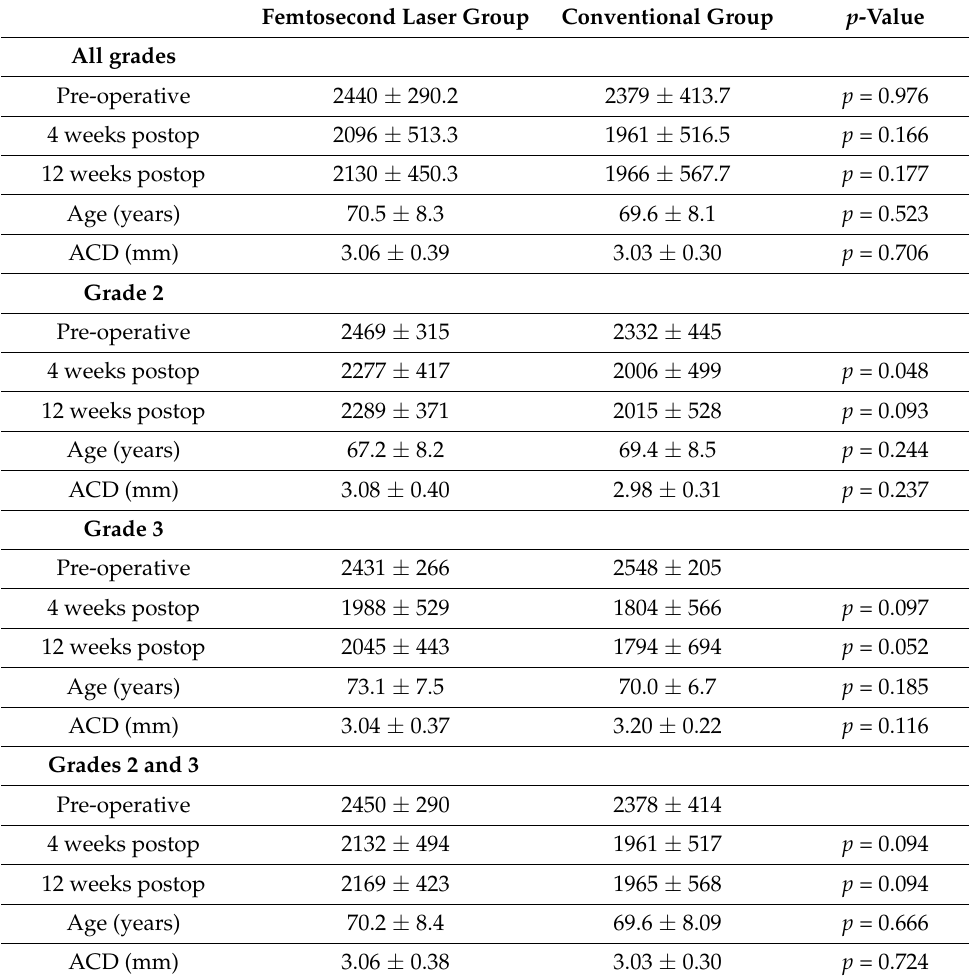
Table 2. Comparison of corneal endothelial cell density (CD, in cells/mm 2 ), the age of subjects, and the ACD between the femtosecond laser and the conventional group, over time for all eyes, and split into